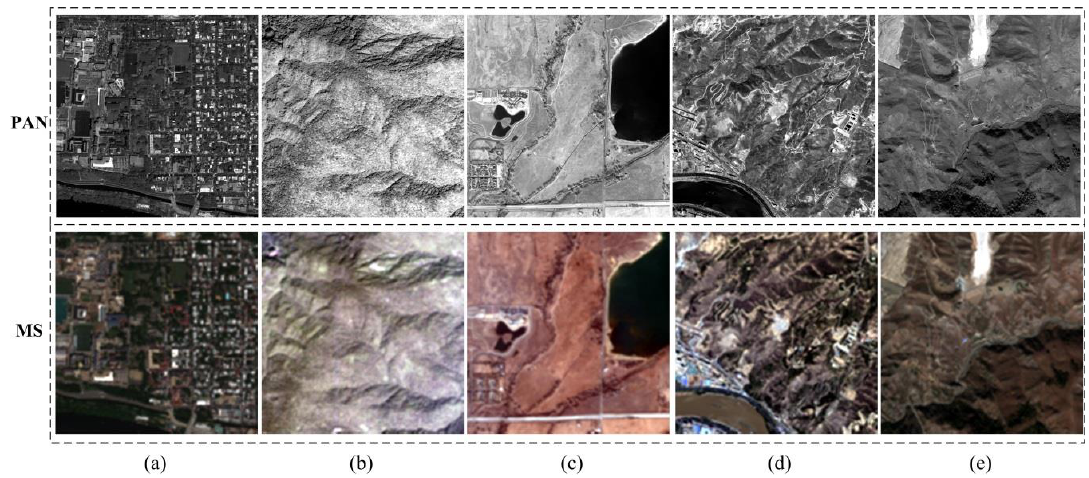
Figure 7. Datasets of pansharpening experiments. ( a ) Washington dataset. ( b ) Sichuan dataset. ( c ) Boulder dataset. ( d ) Lanzhou dataset. ( e ) Xinjiang dataset. Table 1. Datasets for experiments.